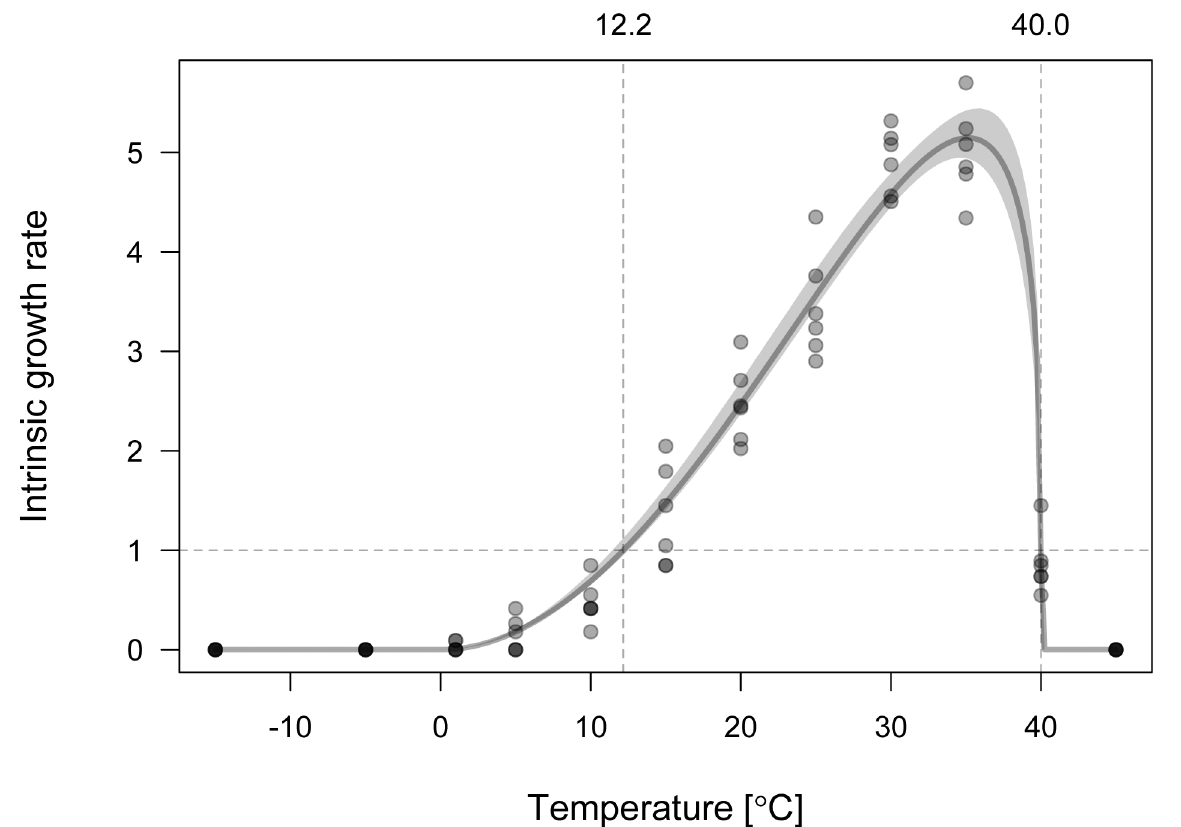
Fig 2. Relationship between temperature and population growth rate for Aceria tosichella lineage MT-1. Vertical dashed lines denote temperature ranges within which the population increases in numbers. Shaded region represents standard error band.